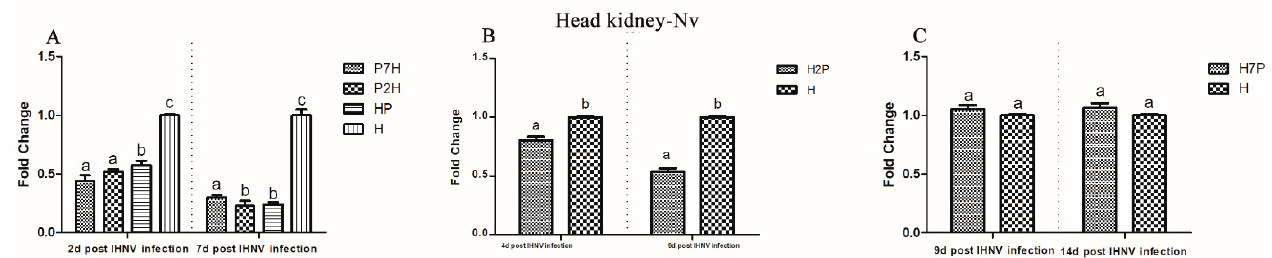
Figure 8. IHNV Nv genes in the head kidney determined by qRT-PCR. Rainbow trout challenged with IHNV (group H) were used as controls. Different letters on the bar charts indicate statistically significant differences ( p < 0.05). ( A ) The levels of IHNV Nv gene in groups P7H, P2H, and HP. ( B ) The levels of IHNV Nv gene in group H2P. ( C ) The levels of IHNV Nv gene in group H7P.